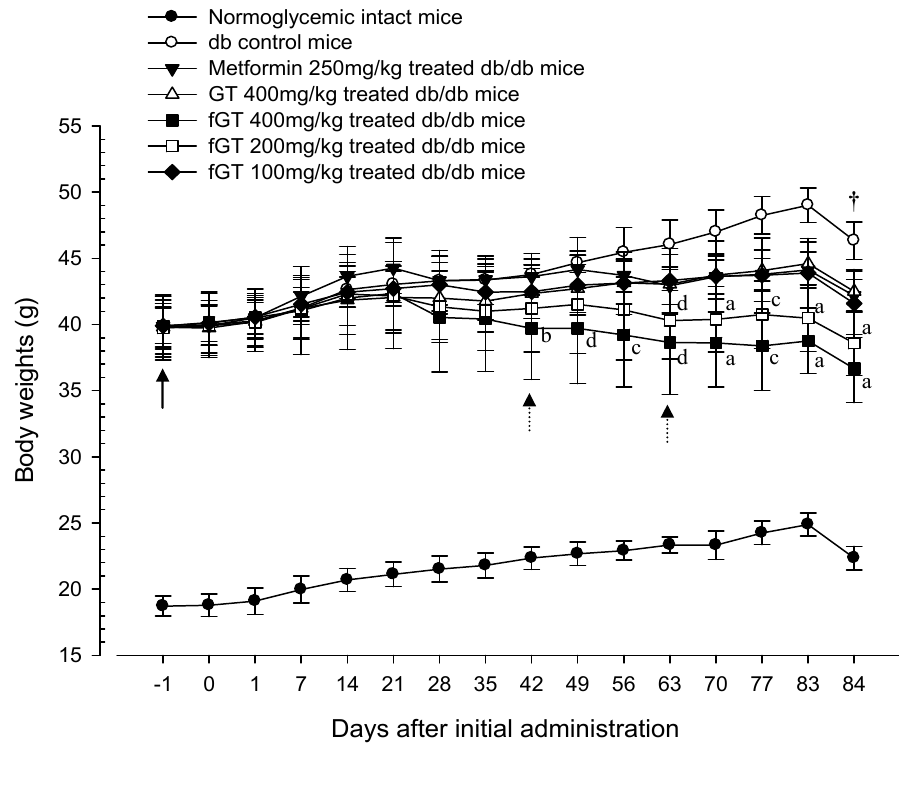
Figure 1. Body weight changes in intact Normoglycemic and db/db mice. Values are expressed as mean ± SD of eight mice. GT, Green tea aqueous lyophilized extracts; fGT, Aquilariae Lignum-fermented green tea aqueous lyophilized extracts. All animals were overnight fasted before sacrifice. a p < 0.01 and b p < 0.05 as compared with GT 400 mg/kg by LSD test; c p < 0.01 and d p < 0.05 as compared with GT 400 mg/kg by MW